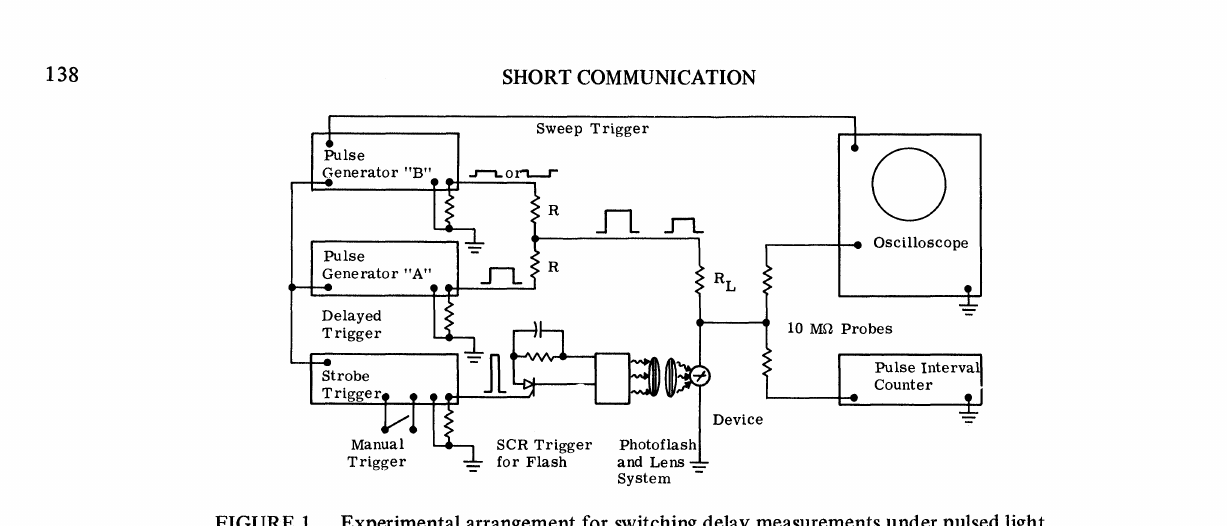
Experimental arrangement for switching delay measurements under pulsed light.